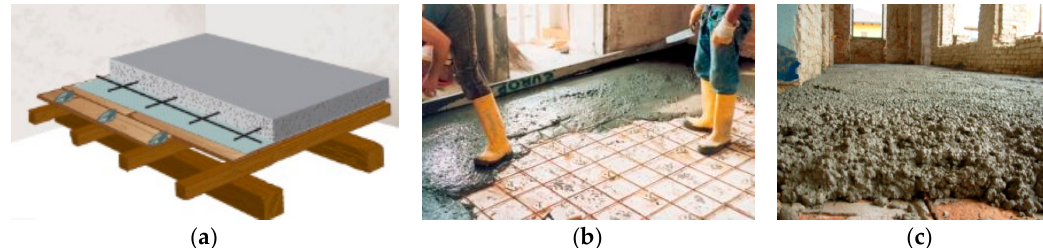
Figure 28. Traditional reinforcement of one-way wooden floor. A steel mesh reinforced concrete slab is applied over the wooden floors (there are no connections between the slab and the timber beams or rafters): ( a ) schematic arrangement; ( b ) RC slab application; ( c ) use of autoclaved aerated concrete; to reduce the RC slab weight (dead loads).